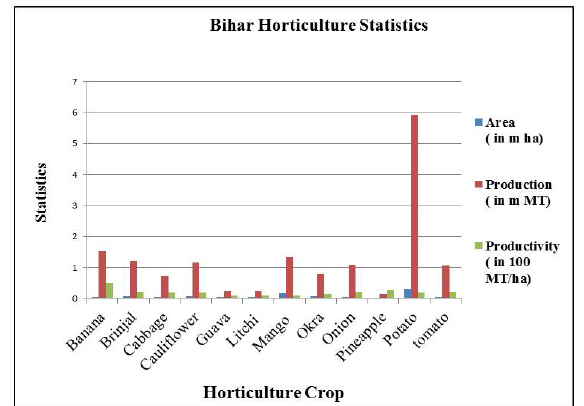
Figure 3. Major horticulture crop statistics (area, production and productivity) of Bihar State